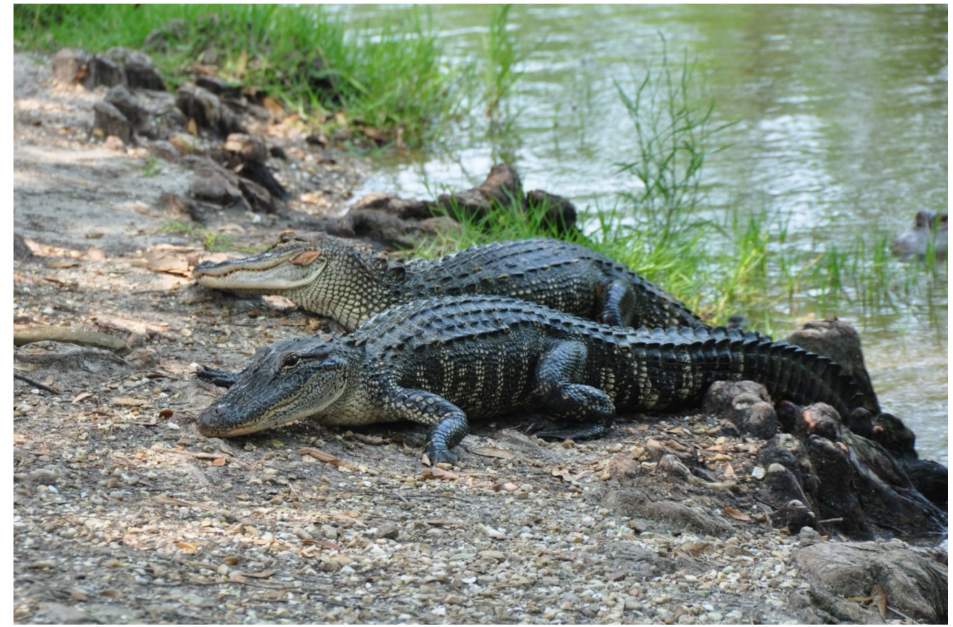
Figure 14. Example of American alligators in their natural wetland habitat of Louisiana. Source: Edward